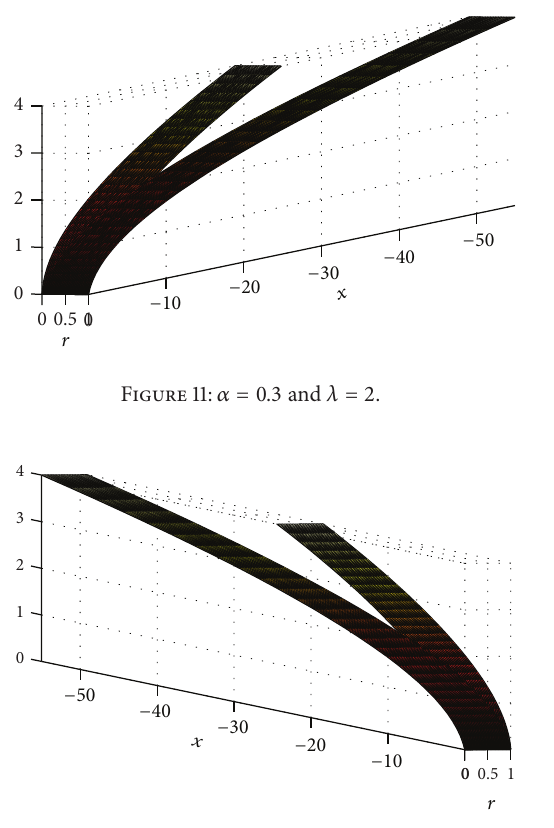
Figure 12: 𝛼 = 1 and 𝜆 = 2 .